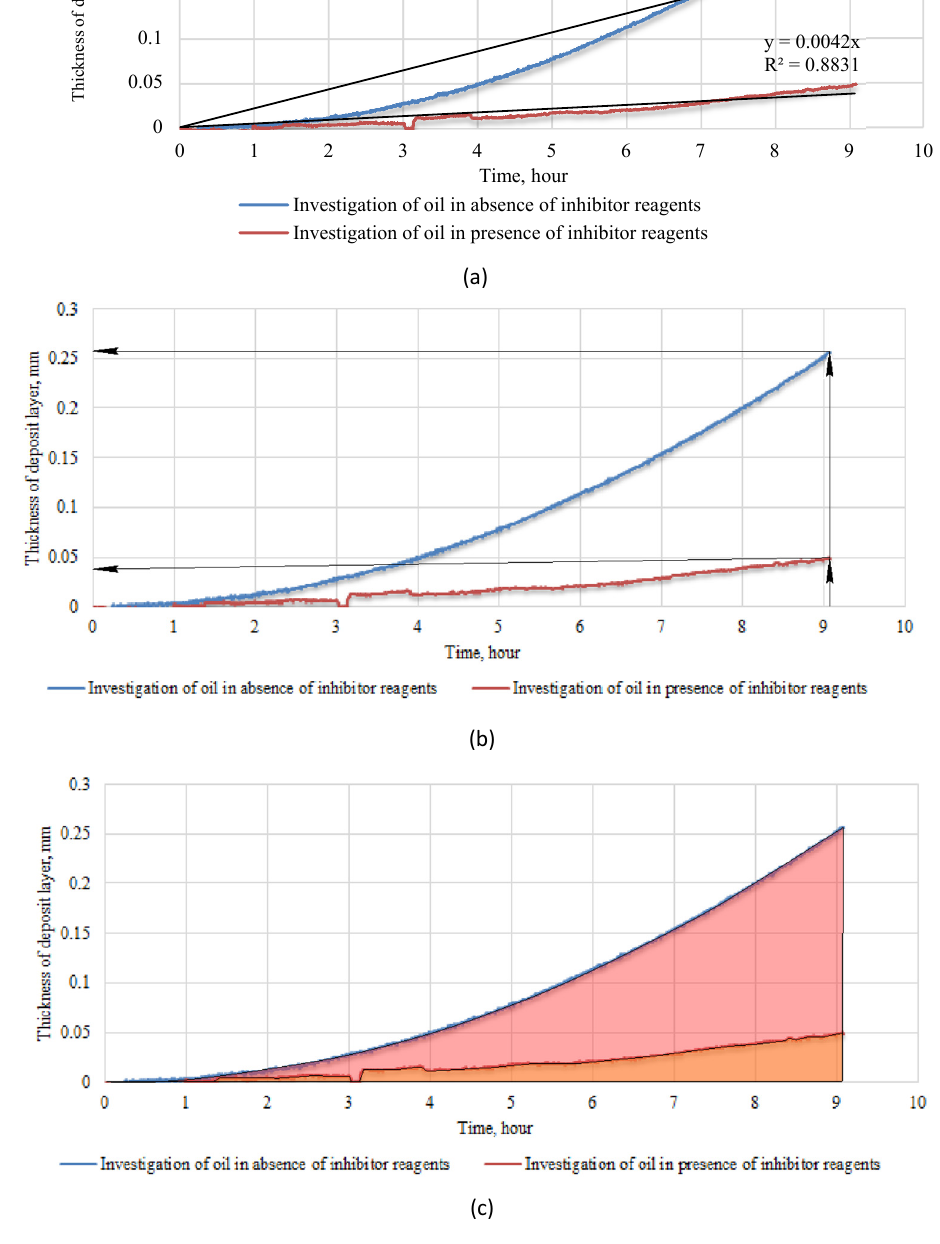
Figure 6. Graphic representation of methods for assessing the effectiveness of inhibitors: approxima- tion by a linear law ( a ), the ratio of maximum thicknesses ( b ) and integration ( c